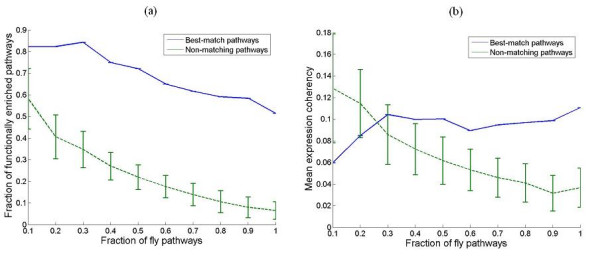
Functional significance of best-match pathways infly Functional enrichment (a) and expression coherency (b) of fly best-match pathways obtained by QPath compared to fly pathways that are not the result of a query. x-axis: Fraction of best-match pathways in fly. y-axis in (a): Fraction of functionally enriched pathways out of the set of pathways determined by x. y-axis in (b): Mean expression coherency of the pathways determined by x. The random pathway curves show the mean and standard deviation of the functional enrichment and expression coherency computed for random choices of pathway sets in fly.